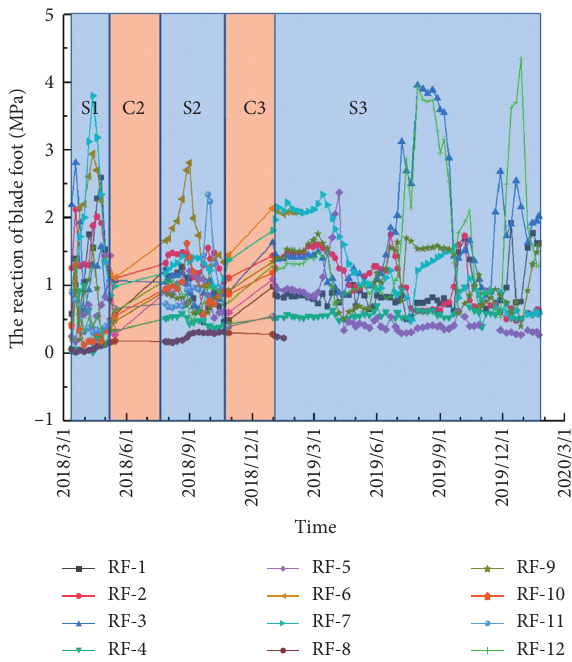
Figure 9: The change of blade foot reaction stress during caisson excavation.